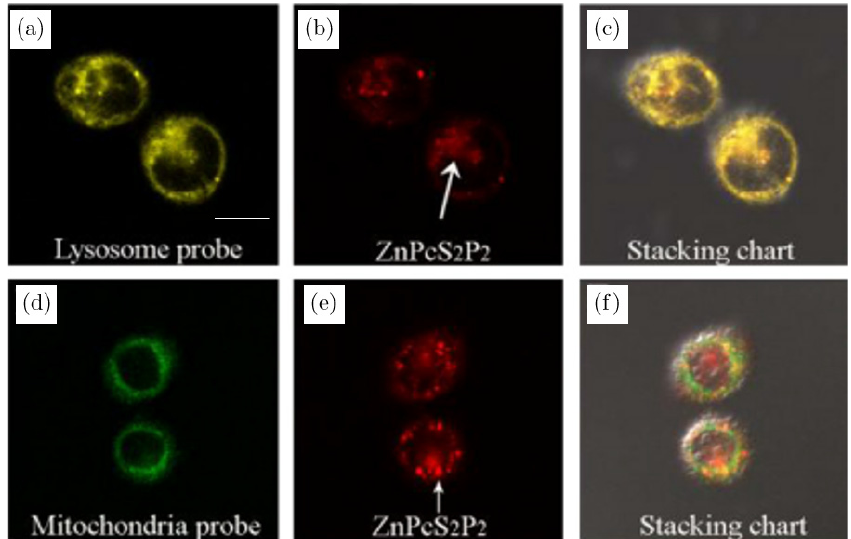
Fig. 5. Intracellular distribution of Photocyanine in HepG2 without irradiation. Lysosome (a) and mitochondria (d) were stained with LysoTracker Red (emitted at 577 nm) and Mito-Tracker Green (emitted at 490 nm), respectively. (b) and (e) showed intra- cellular Photocyanine accumulation (10 (cid:2) M) detected by red °uorescence. (c) and (f) showed stacked pictures of the red granular Photocyanine particles with yellow lysosome (c) and green mitochondria (f), respectively (original magnification (cid:5) 60, bar ¼ 20 (cid:2) m). Reproduced with permission from Ref. 35.